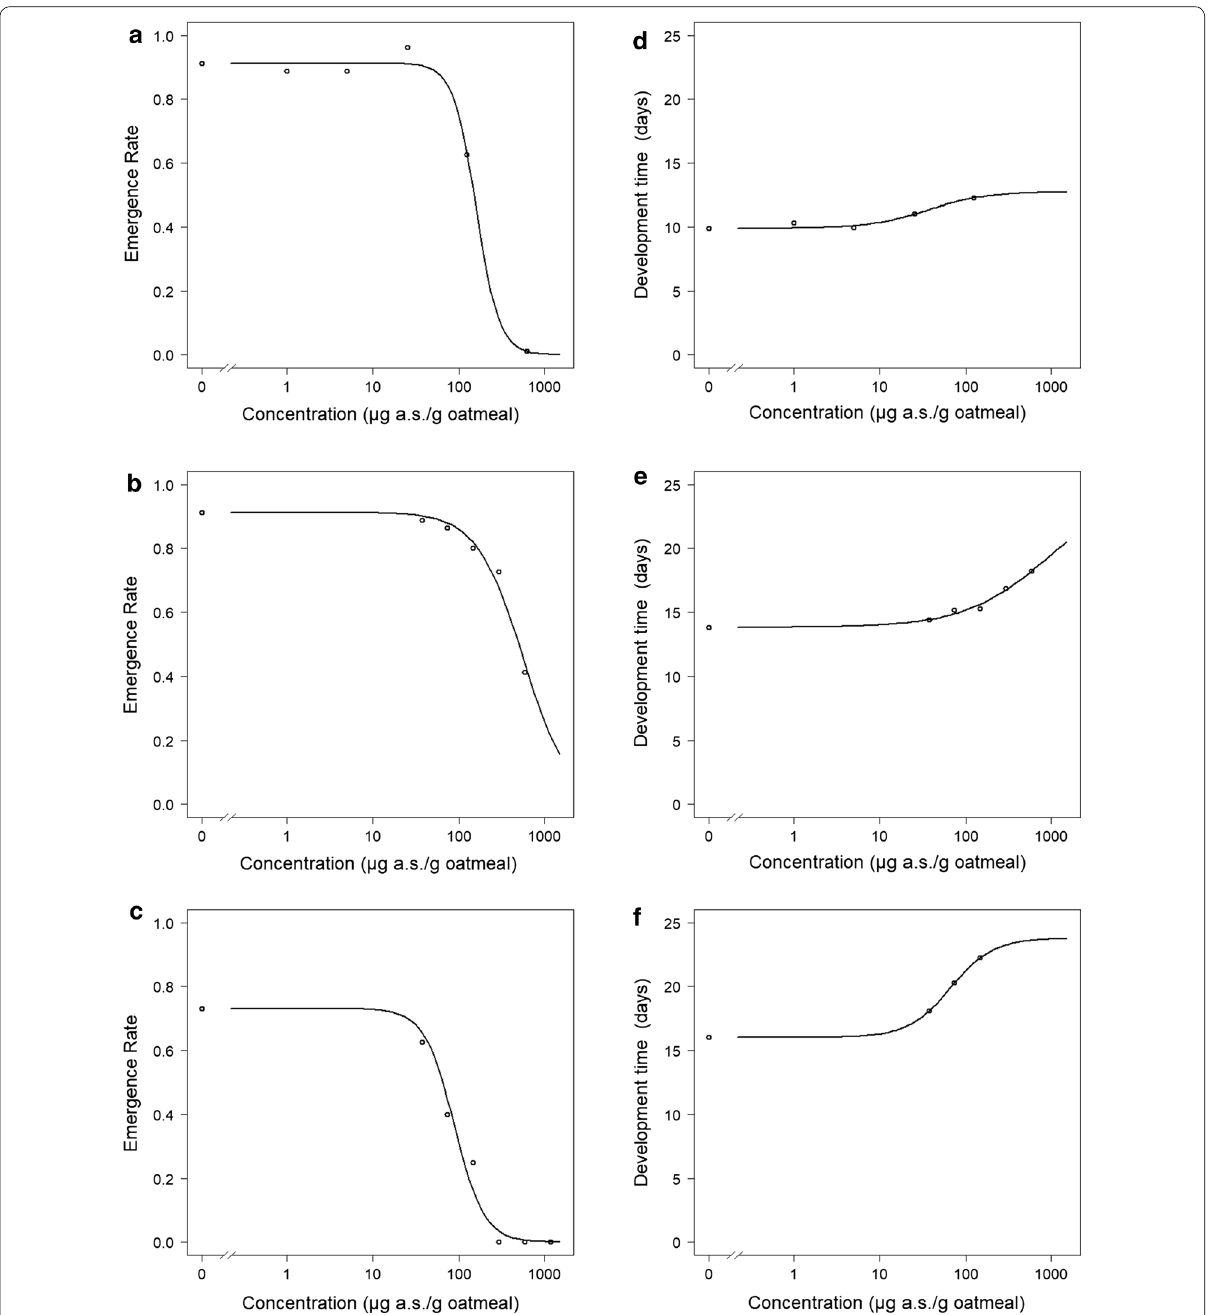
Fig. 6 Concentration–response curves for the effect of azadirachtin on B. impatiens . a Emergence rate (ER) in coconut fiber substrate (CFS) at 25 °C; b ER in CFS at 20 °C; c ER in tropical artificial soil (TAS) at 20 °C; d development time (DT) in CFS at 25 °C; e DT in CFS at 20 °C; f DT in TAS at 20